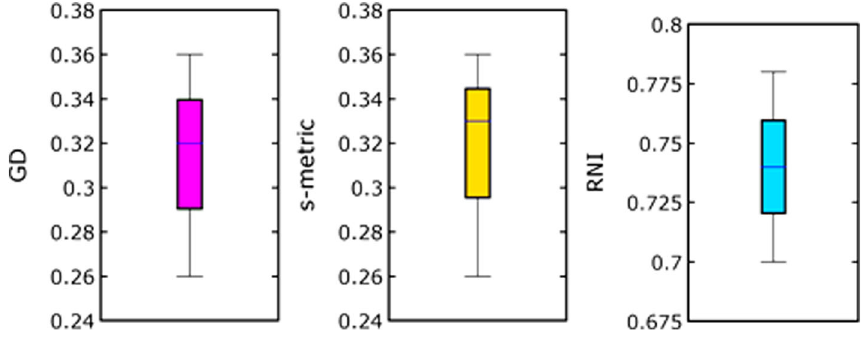
Fig. 9 Boxplots of multi-objective performance measures